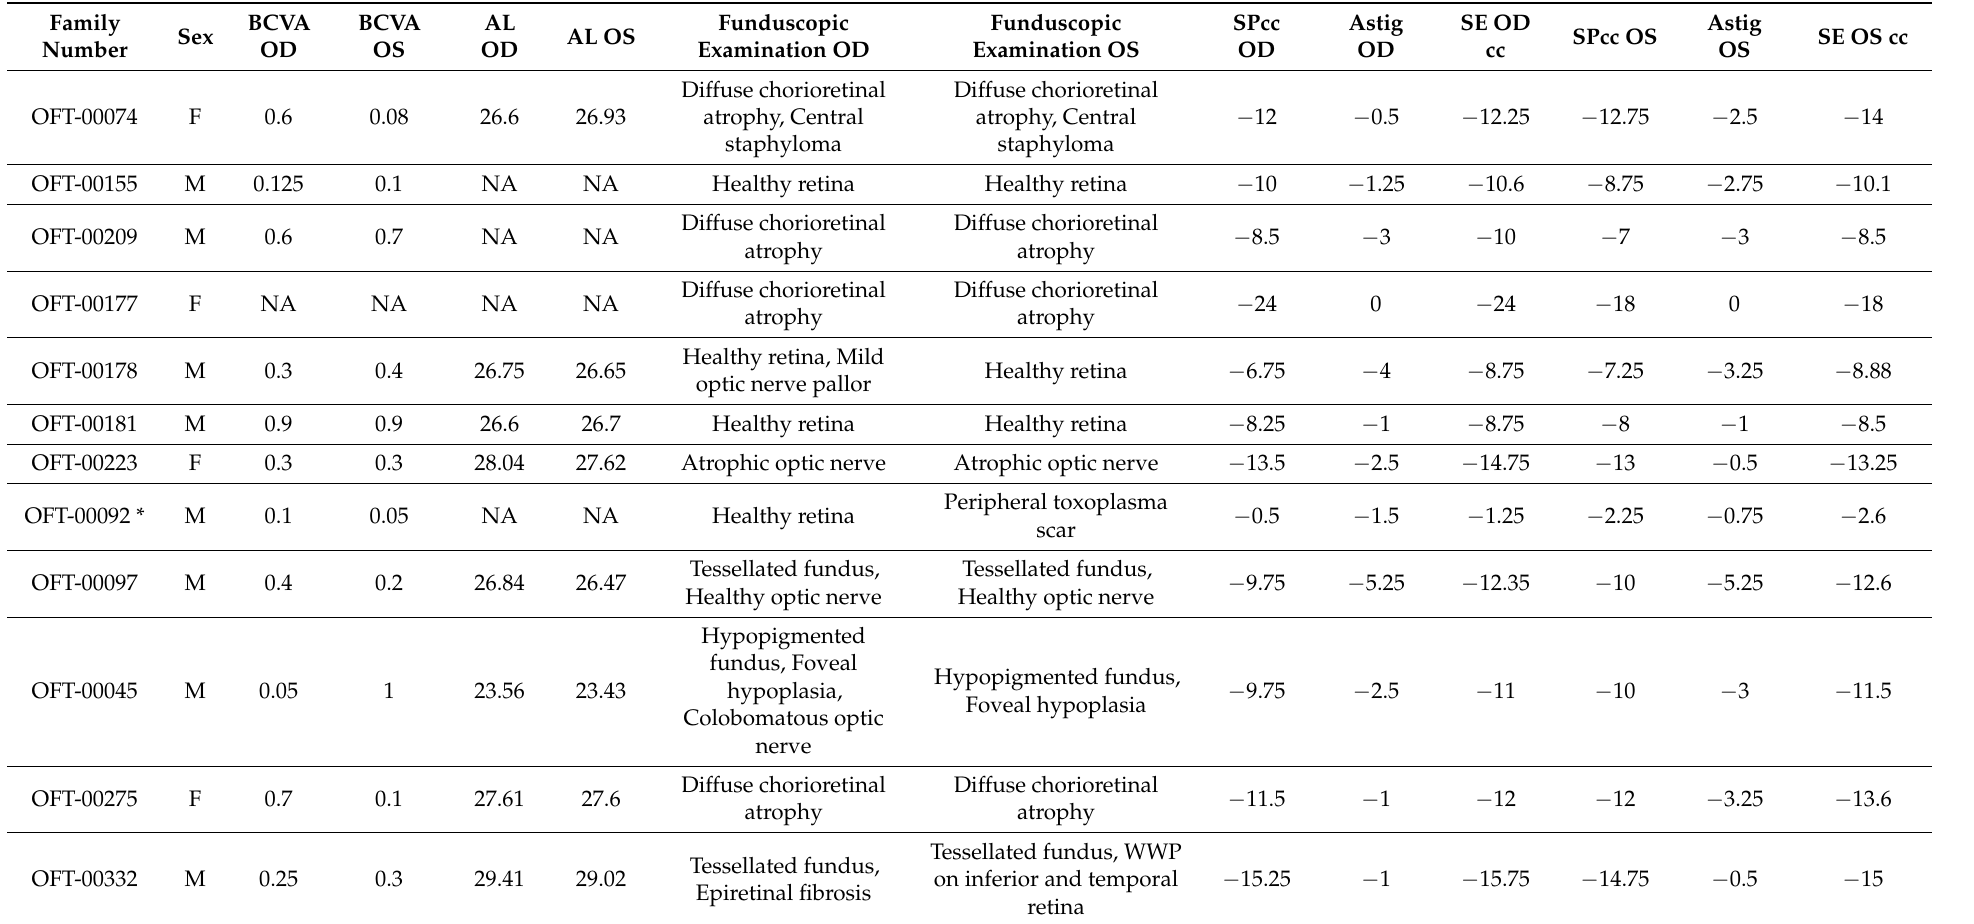
Table 2. Clinical Evaluation of